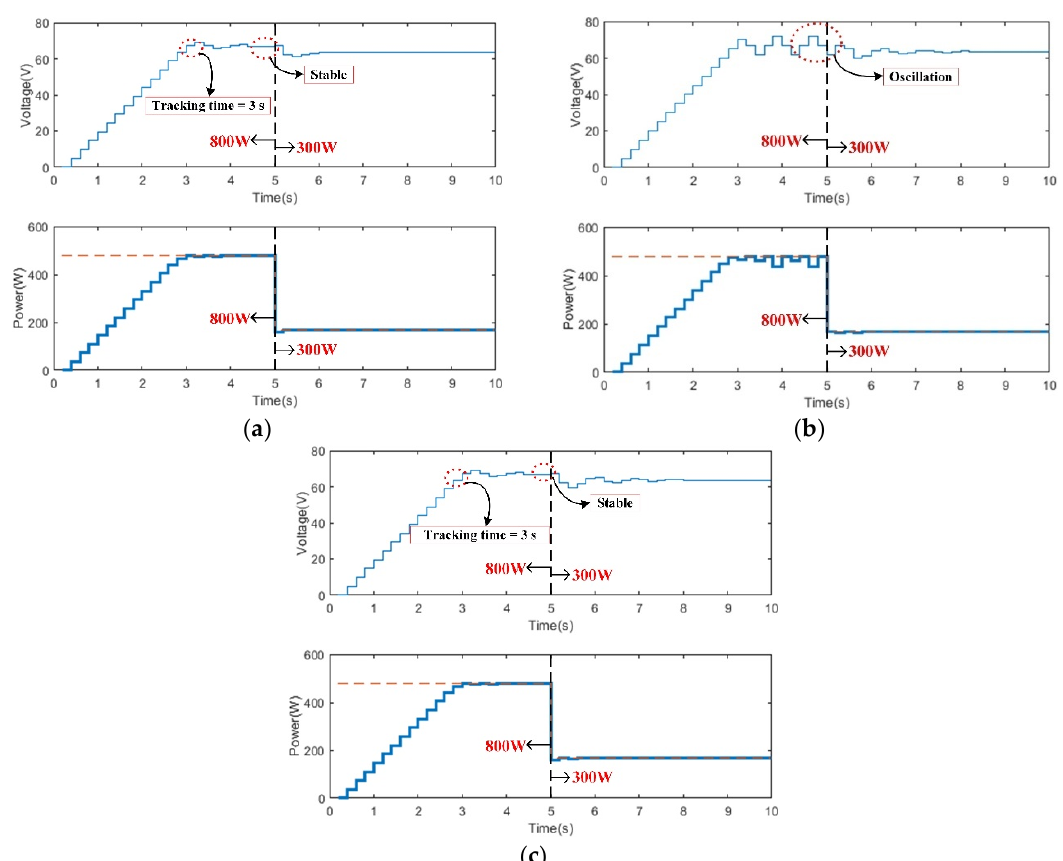
Figure 5. Simulation results of different M values ( a ) M = 0.65, ( b ) M = 1.8, ( c ) M = 0.65/1.8 under decreasing irradiance levels.